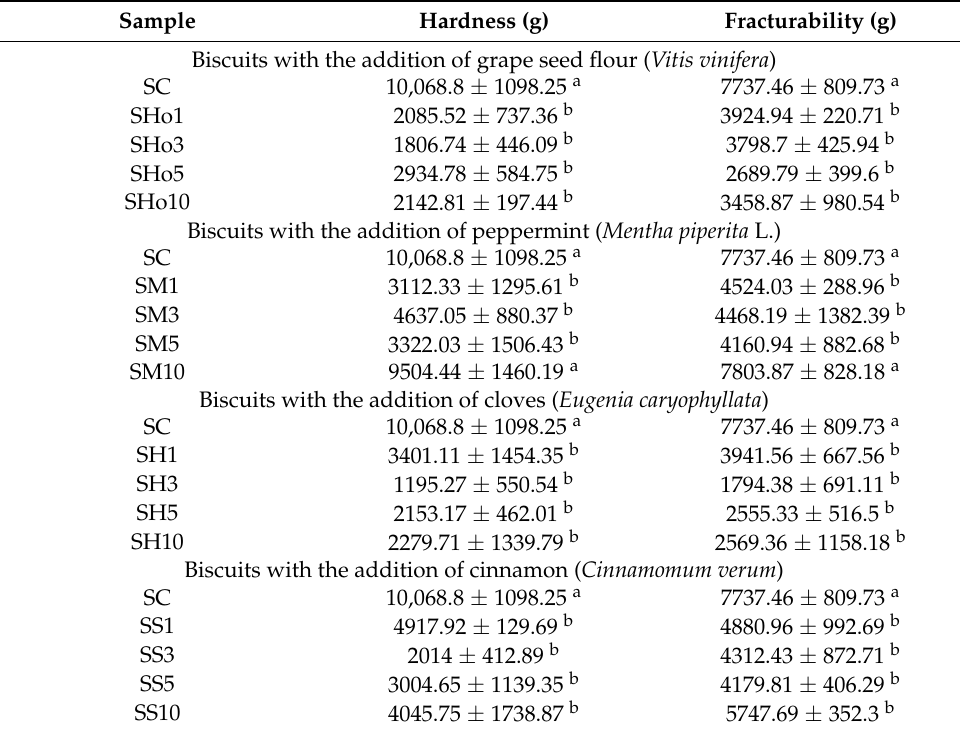
Table 2. Textural parameters in the samples of